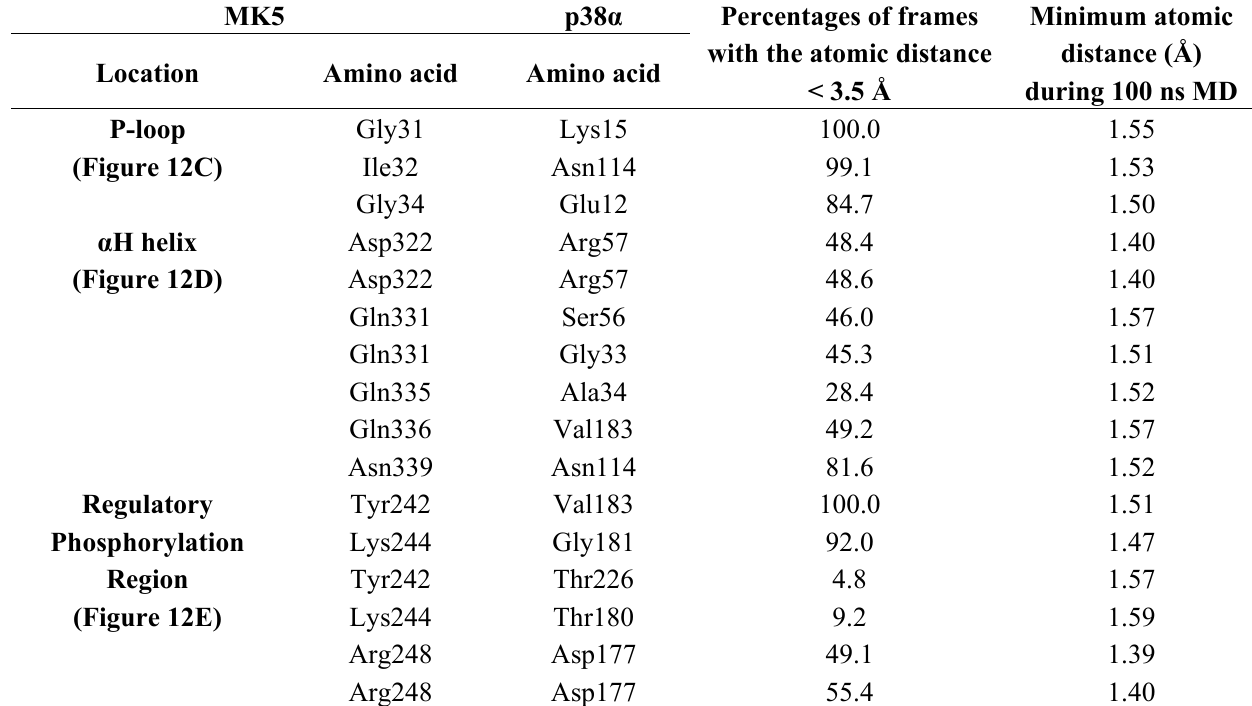
Figure 12. A close up of interacting amino acids forming the MK5-p38 α interface. MK5 is in grey ribbon, while p38 α is in yellow ribbon. Dashed lines indicate interactions between amino acids in MK5 and p38 α . The percentages indicate the percentages of MD frames with the particular interacting atomic distance <3.5 Å. ( A ) the activation segment of